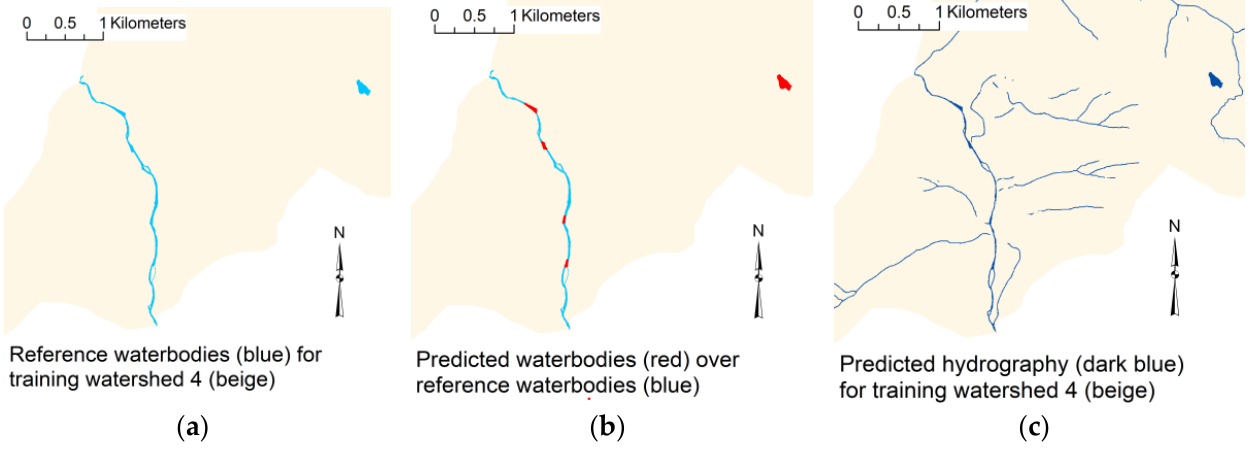
Figure 10. ( a ) Reference hydrography, ( b ) waterbodies extracted from predictions (red) displayed over reference waterbodies, and ( c ) predicted hydrography pixels from model 14 for a section of reference HU12 watershed 4 (190503021004).